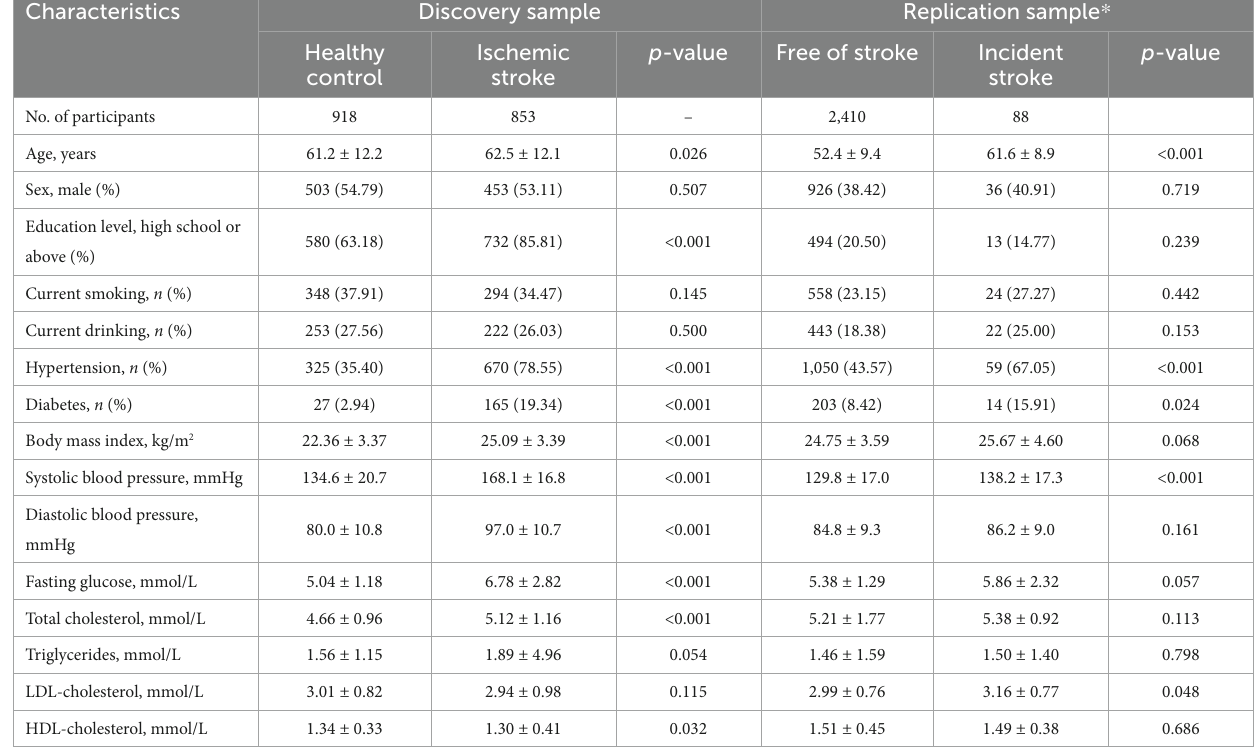
TABLE 1 Clinical characteristics of participants in the discovery and replication samples.